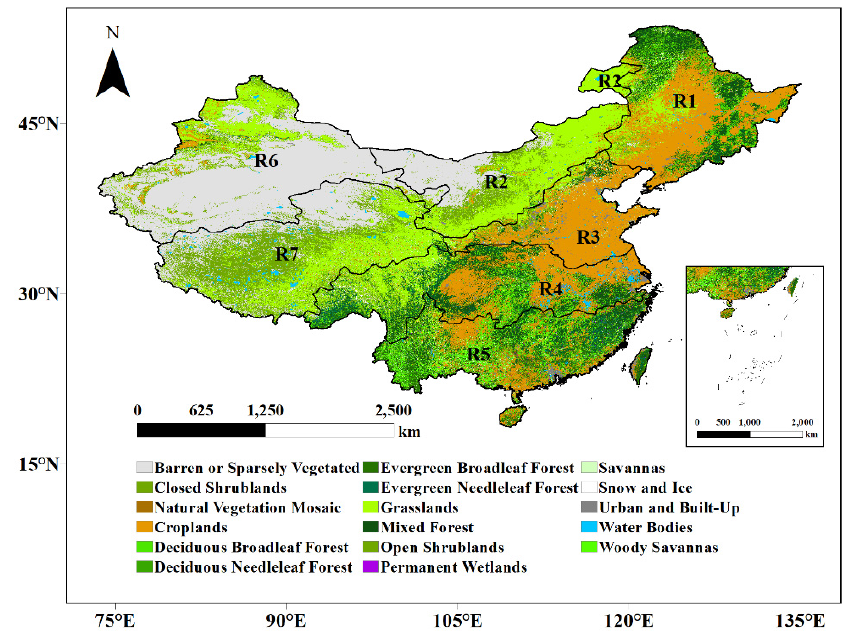
Figure 1. Ecological and geographical divisions and their land cover in China. The land cover data are from MODIS Land Cover Type Product (MCD12Q1, available online: https://doi.org/10.5067/ MODIS/MCD12Q1.006 accessed on 1 September